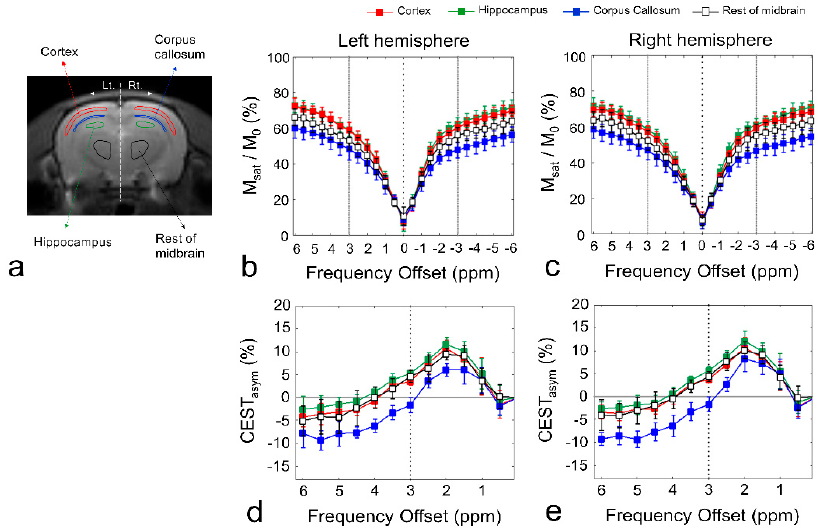
Figure 1. Regions of interest (ROIs) for quantitative analysis of chemical exchange saturation transfer (CEST) data ( a ). Z-spectra ( b , c ), and asymmetry curves ( d , e ) for each ROI in the left hemisphere and right hemisphere. All square data points indicate mean values ( n = 11), and error bars represent standard deviation. The Z-spectra and calculated CEST asymmetry curves in each ROI are shown in different colors (red, cortex; green, hippocampus; blue, corpus callosum; black, rest of midbrain). The black dotted line in the asymmetry curve ( d , e ) represents glutamate CEST (GluCEST) signal at 3.0 ppm.